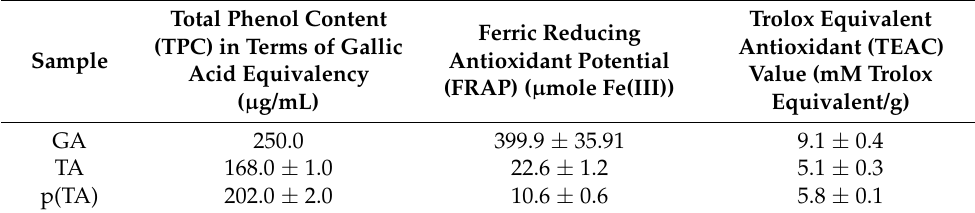
Table 2. Total phenol content (TPC, gallic acid equivalent phenol content), ferric reducing antioxi- dant potential (FRAP), and trolox equivalent antioxidant (TEAC) capacity of p (TA)/200X particles, 0.25